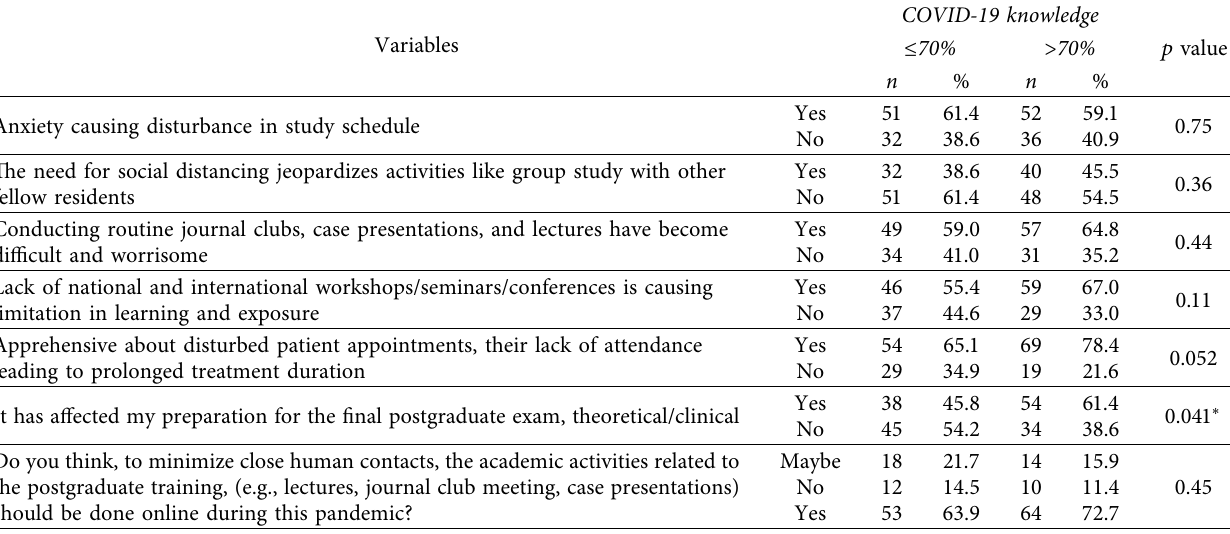
Table 6: Association of COVID-19 knowledge with training related academic/curricular activities studied. Variables